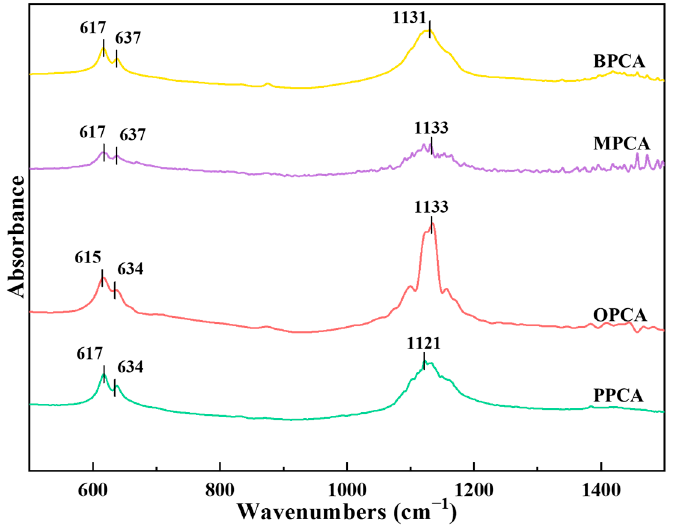
Figure 3. FT-IR spectrums of CAs prepared from different waste biomasses.